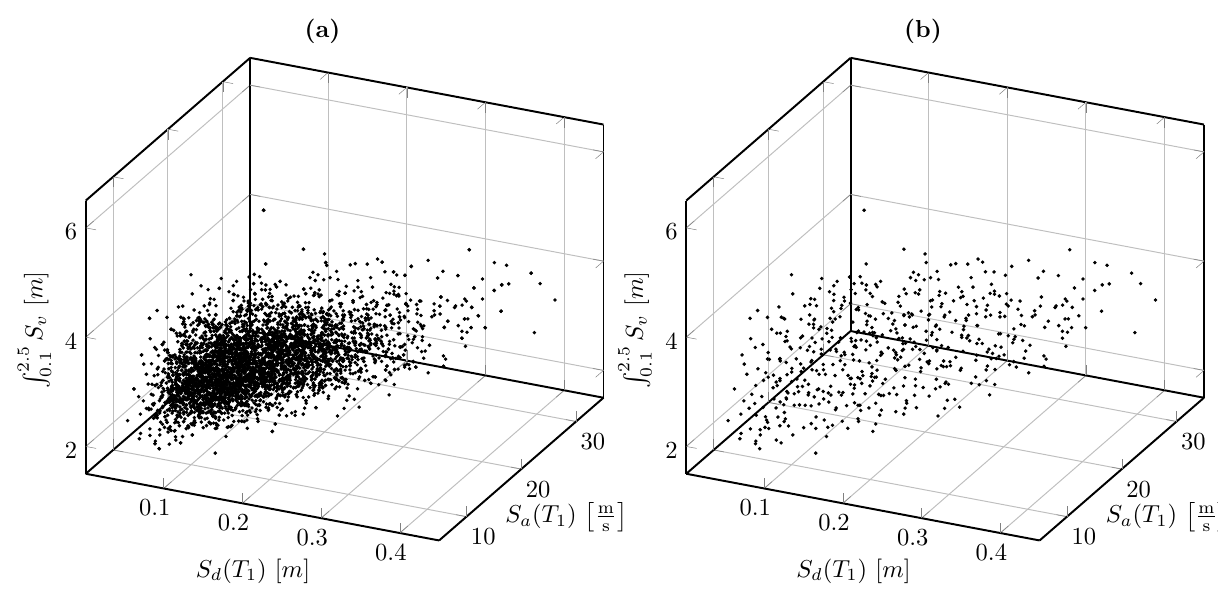
Figure 9. Three-dimensional selection strategy: Selection of samples from ( a ) the full set 2.5 S v , the spectral displacement at the natural period S d ( T 1 ) and the velocity spectrum intensity 0.1 spectral acceleration at the natural period S a ( T 1 ) , and ( b ) selected samples for the training set (cid:82)